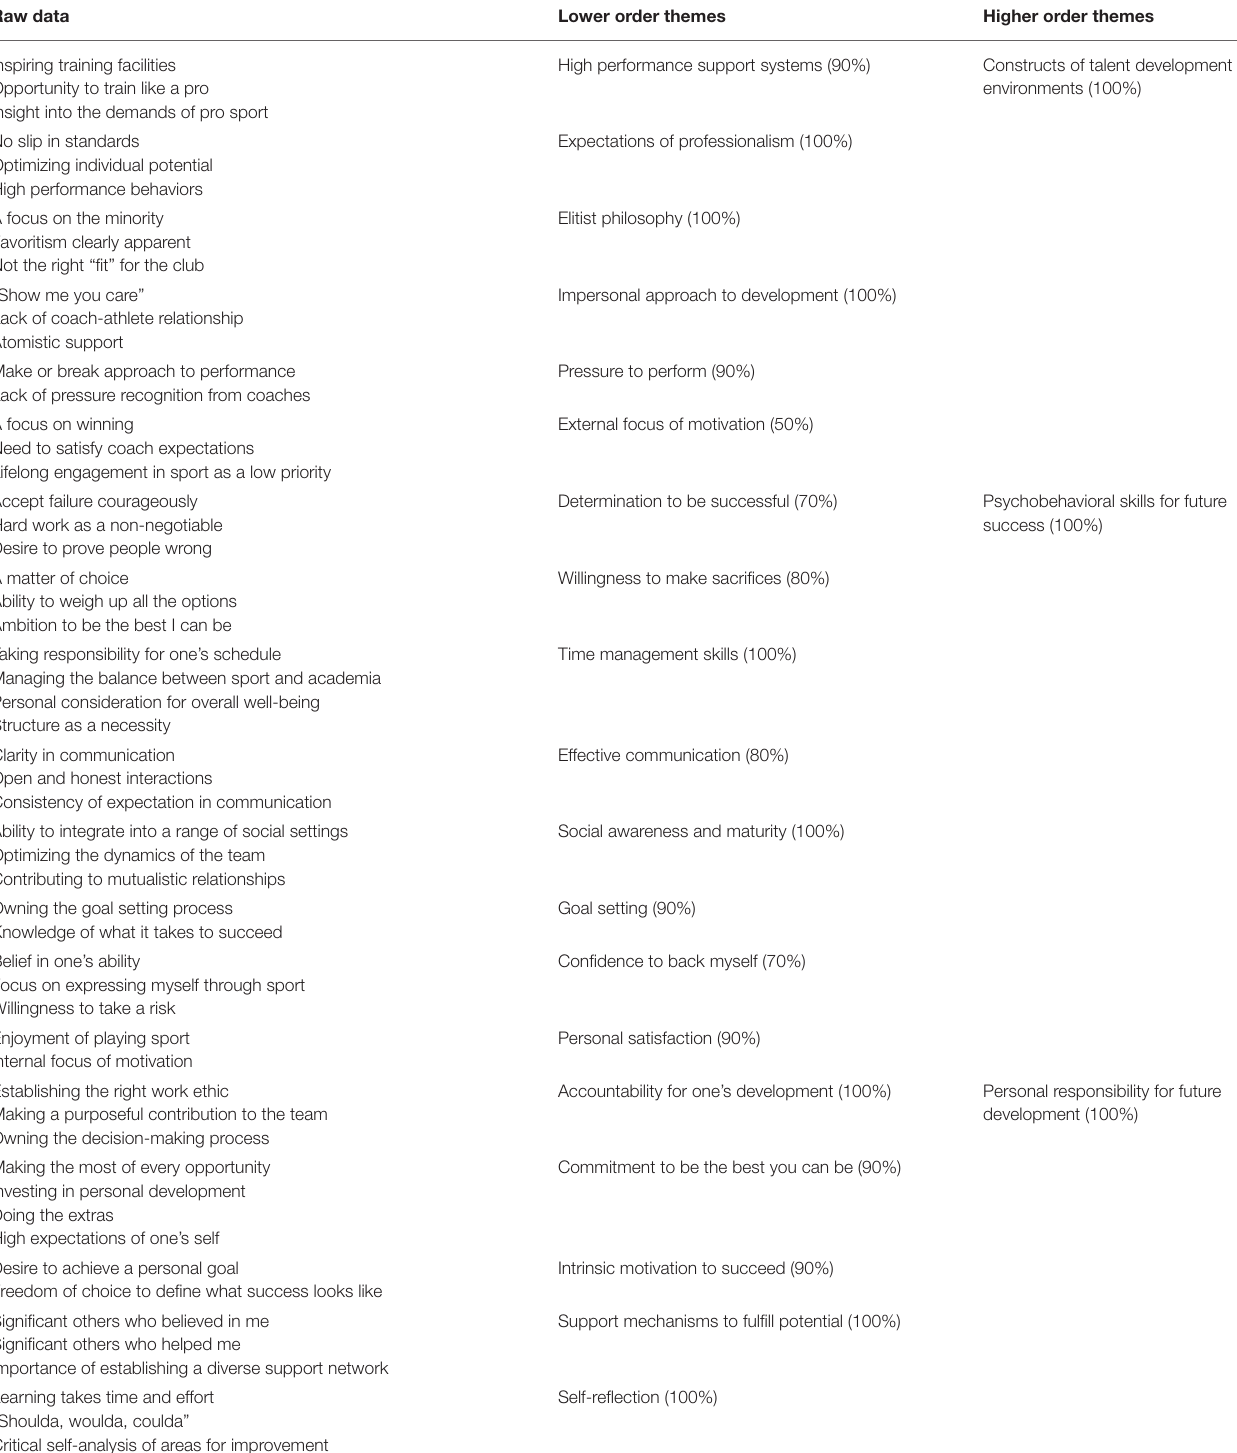
TABLE 2 | Thematic